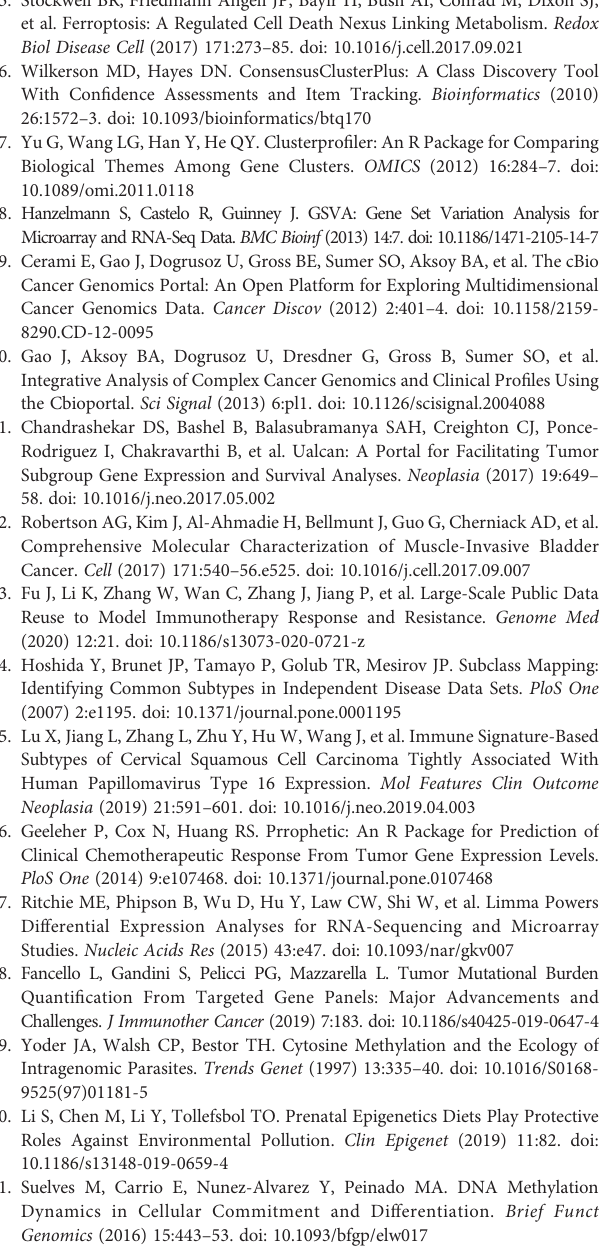
Supplementary Figure 1 | The associations between TFRC mRNA expression levelsandGleasonscore (A) ,nodalmetastasis (B) andmethylationlevels (C,D) inTCGA PCa patients. Subclass mapping (SubMap) analysis of patients respond to anti – PD-1/ PD-L1 treatment (E) . Multiple ROC (Receiver Operating Characteristic) in TCGA and MSKCC (F) . All the survival analysis are based on the recurrence free survival